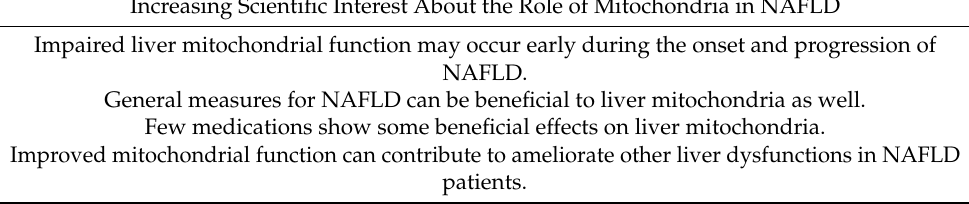
Table 4. Arguments for assessing liver mitochondrial function in NAFLD